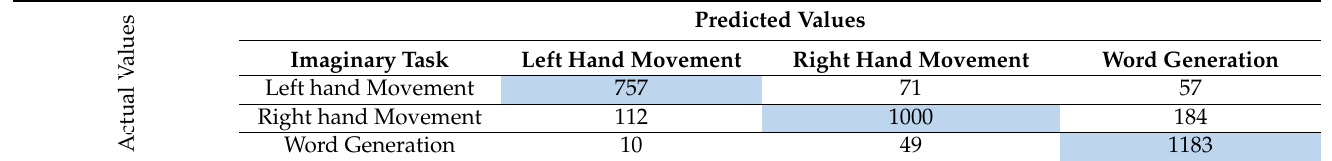
Table 4. Confusion matrix of subject 1.